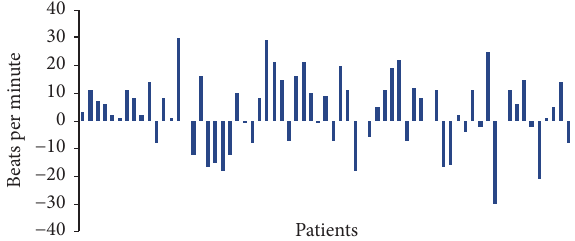
Figure 3: Variation in cardiac rate between Wand and traditional local anesthesia. 41 of the 67 patients had higher rate after injection with the traditional syringe than with the Wand, while 22 showed opposite results.